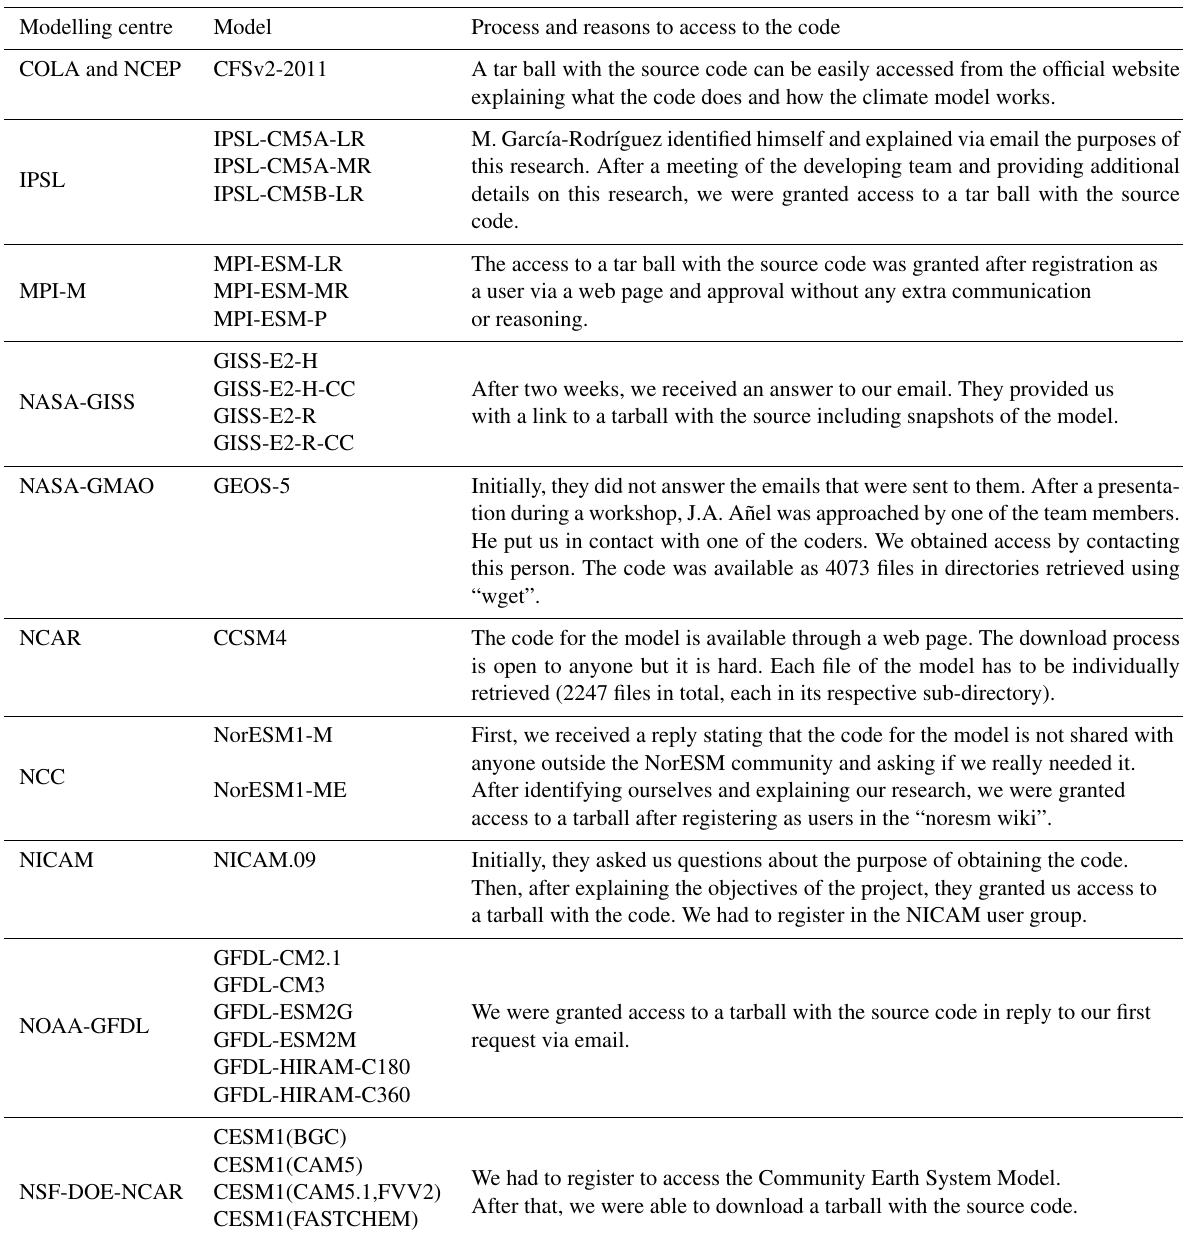
Table 2. Summary of the reasons behind granting us access to the source code for the models. Modelling centre